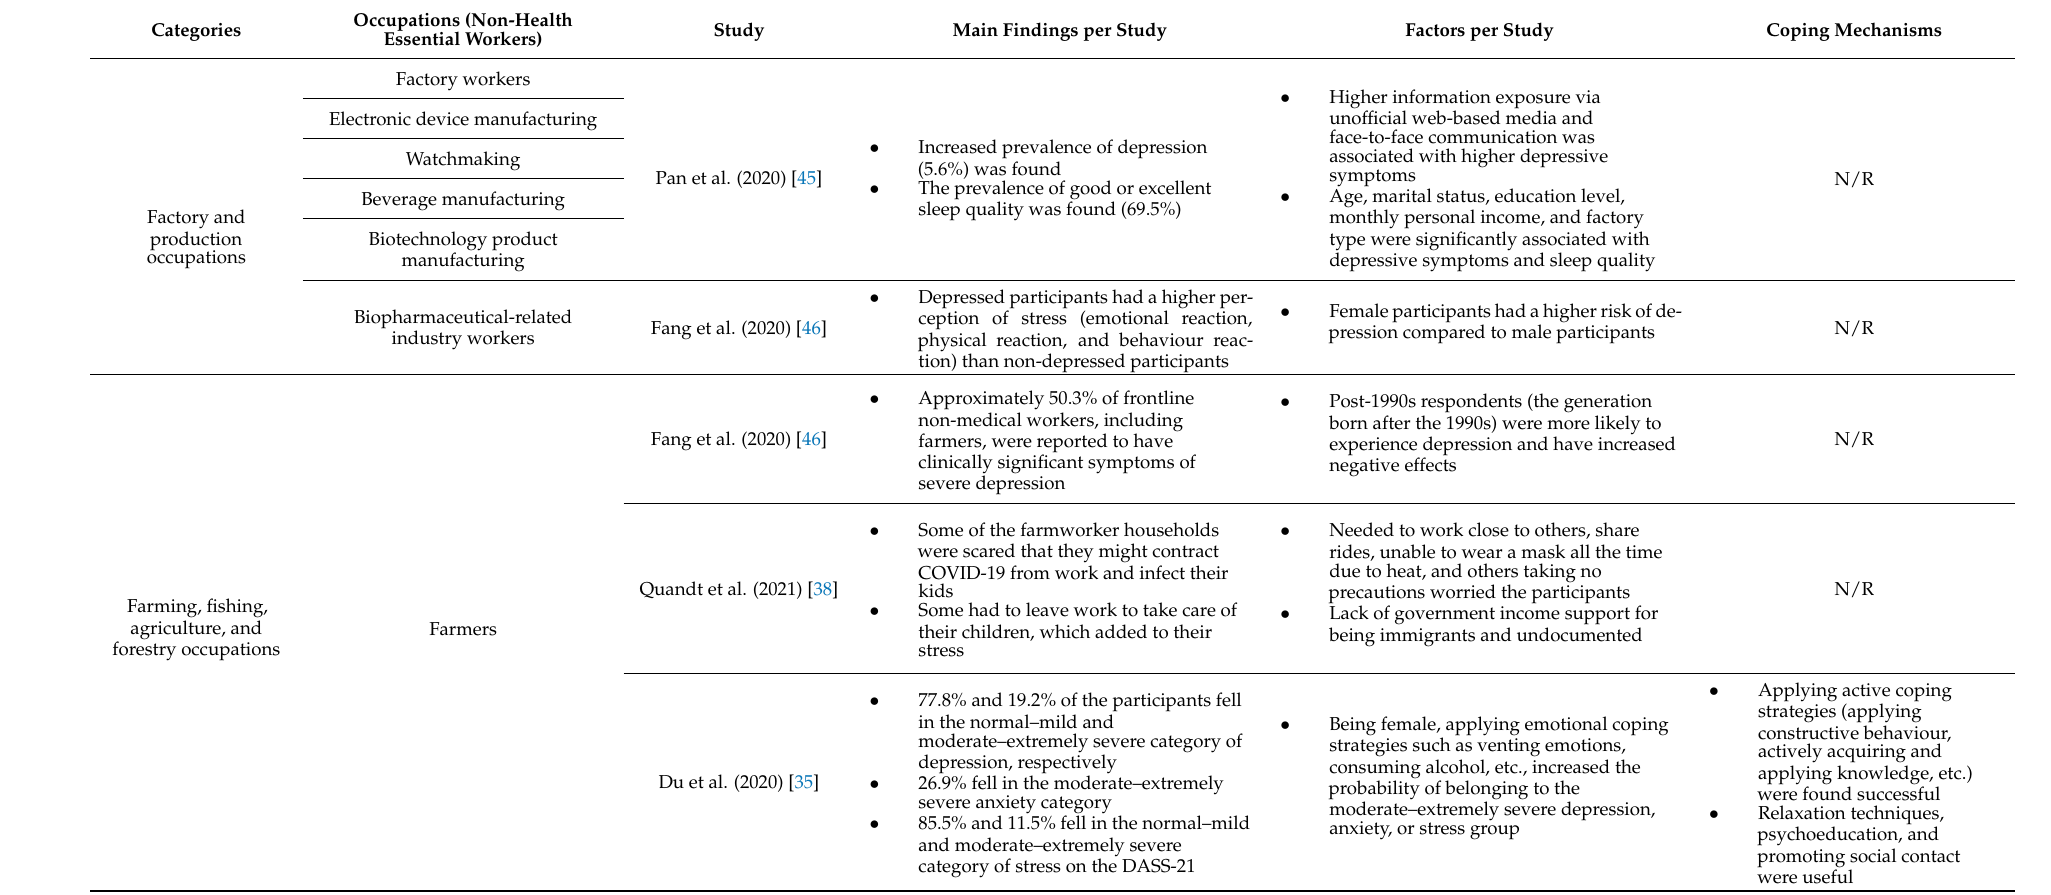
Table 6. Mental health issues, factors, and coping strategies among different categories of non-health essential